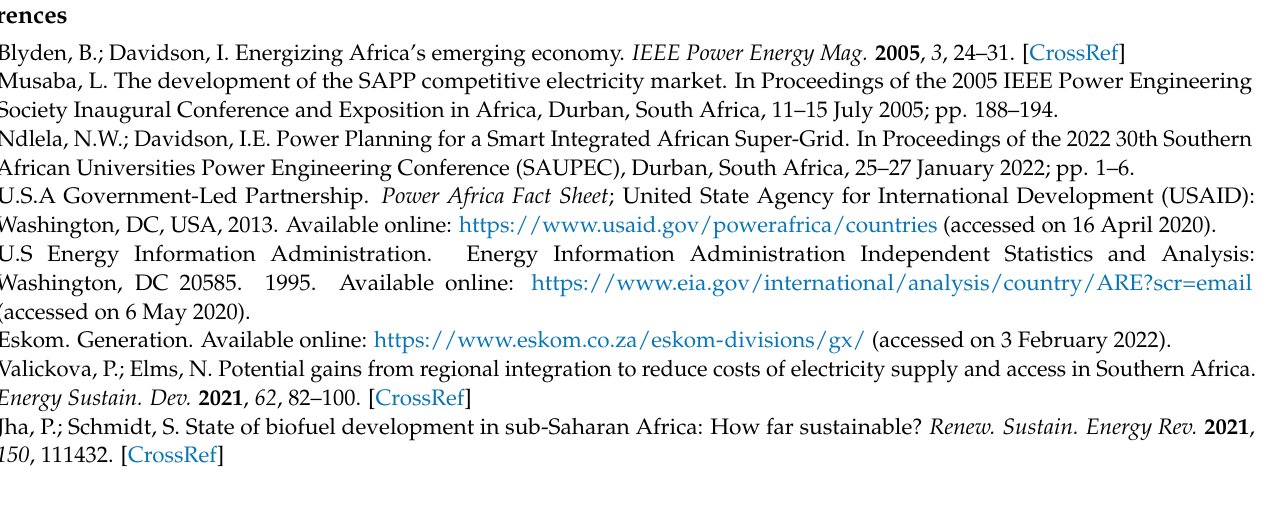
Figure A3. Southern African Regional grid network model with the base case summary of HVAC with the HVDC connection and SVC load flow analysis exhibiting line losses and improved voltage management that enhances grid reliability.